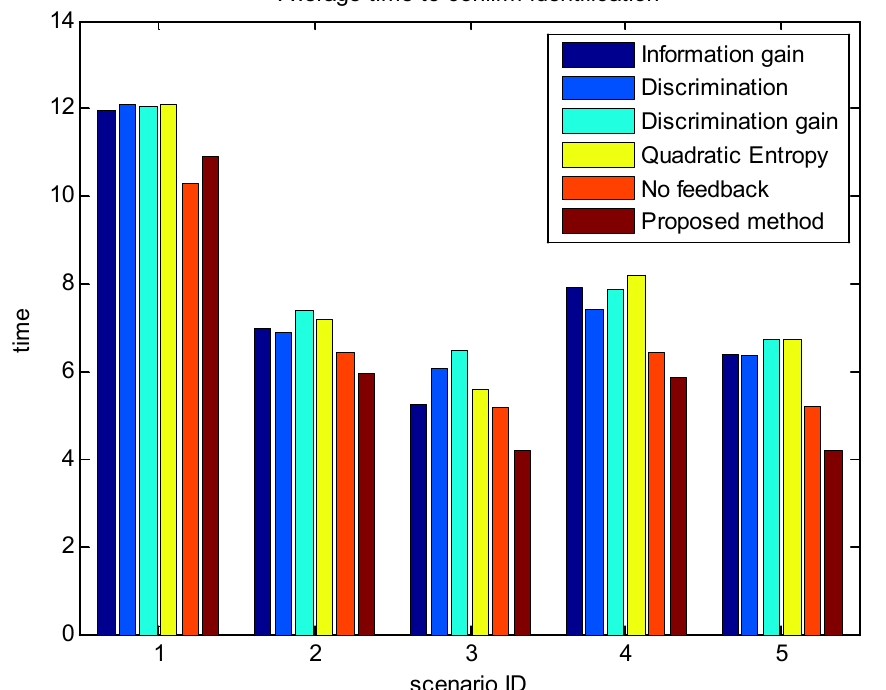
Figure 12. Comparison chart of average confirmation recognition time based on various algorithms under condition 2.